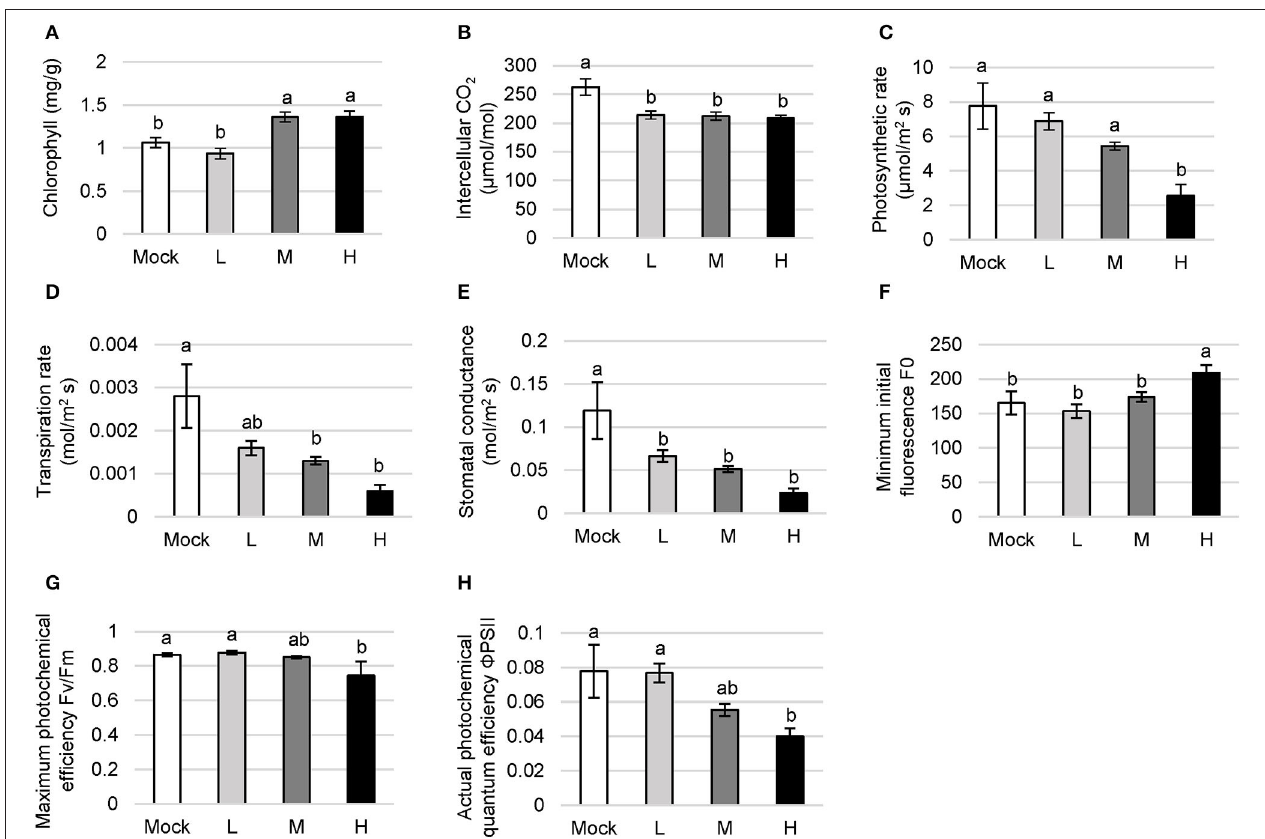
FIGURE 3 | Photosynthetic function in C. inerme to the saline adversity. Content of chlorophyll (A) , photosynthetic rate (B) , transpiration rate (C) , intercellular CO 2 level (D) , stomatal conductance (E) , F0 (F) , Fv/Fm (G) and 8 PSII (H) of C. inerme leaves were determined on day 14 to different levels of NaCl stress. Different letters indicate significant differences among plant groups ( p < 0.05, Mann Whitney test). Mock, no salt control; L, low salt stress; M, medium salt stress; H, high salt stress.